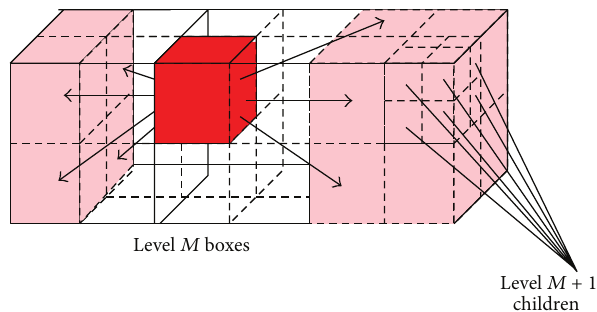
Figure 2: Transmission of the far field expansion to the boxes in its interaction list and translation to the